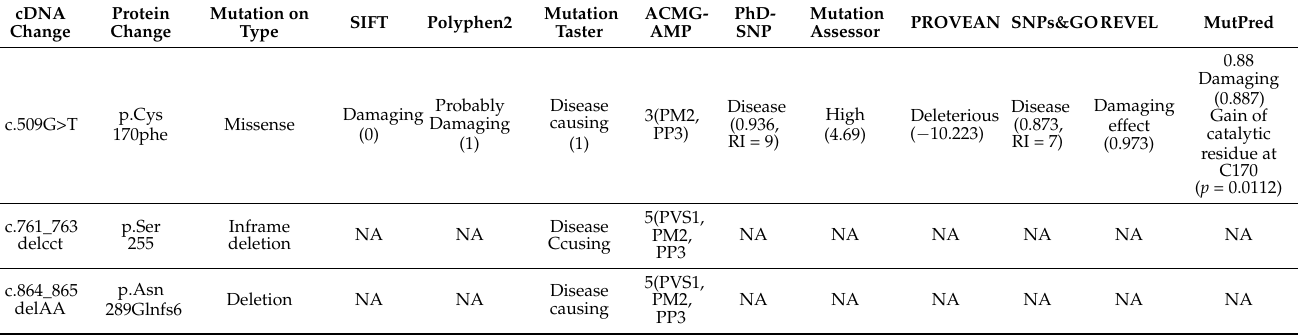
Table 3. The characteristics of the new CTSK gene mutations in the studied